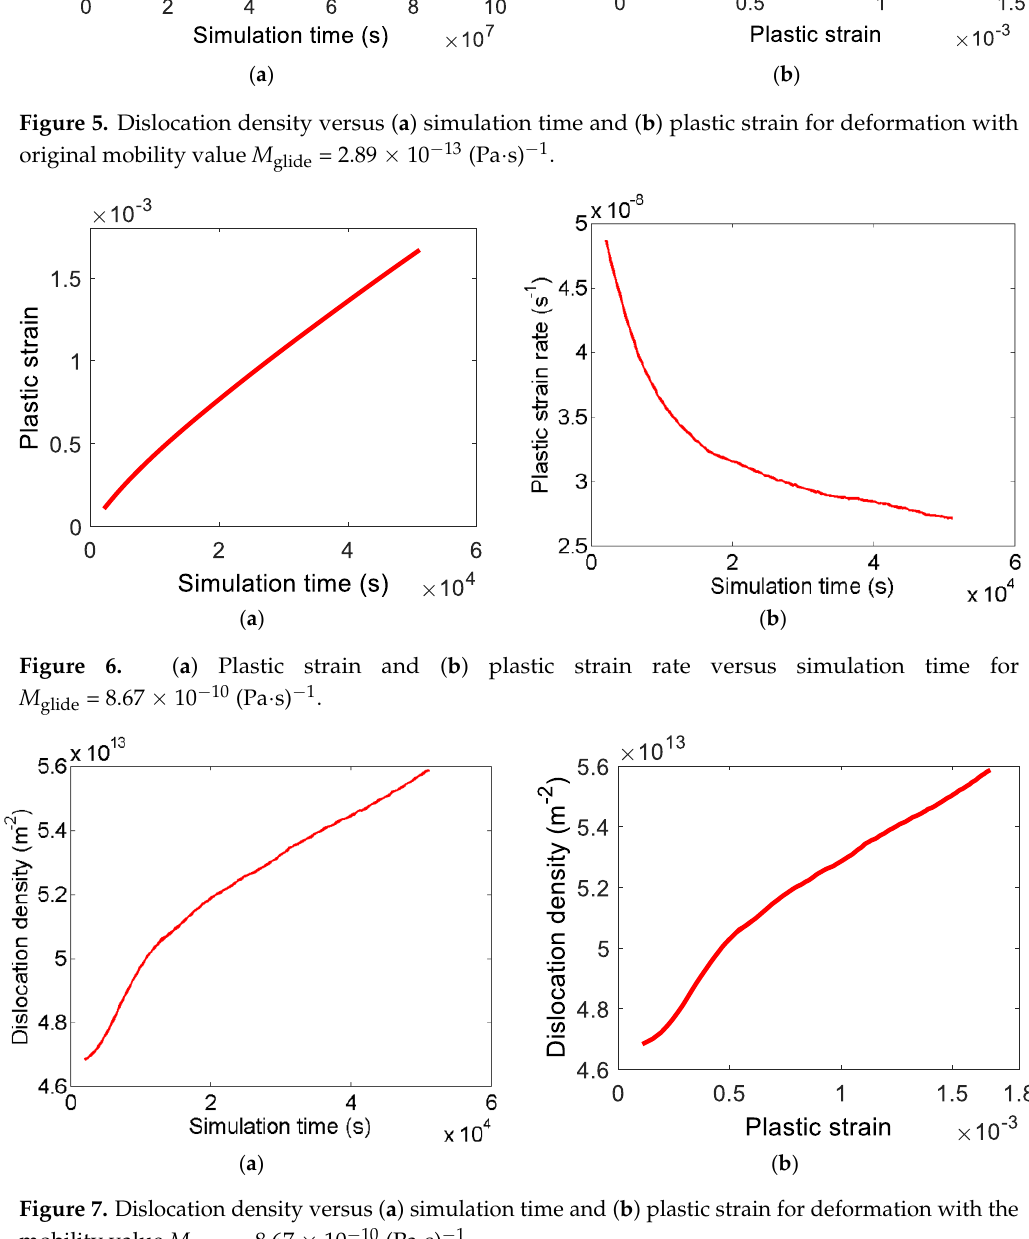
Figure 7. Dislocation density versus ( a ) simulation time and ( b ) plastic strain for deformation with the mobility value M glide = 8.67 × 10 −10 (Pa·s) −1 .